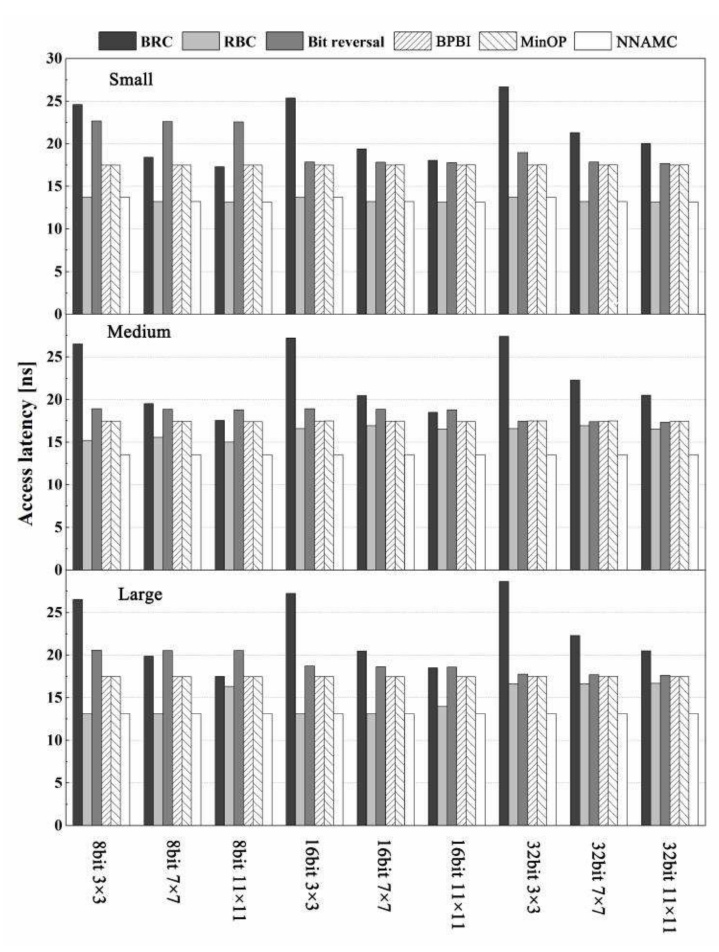
Figure 11. Comparison of average memory access